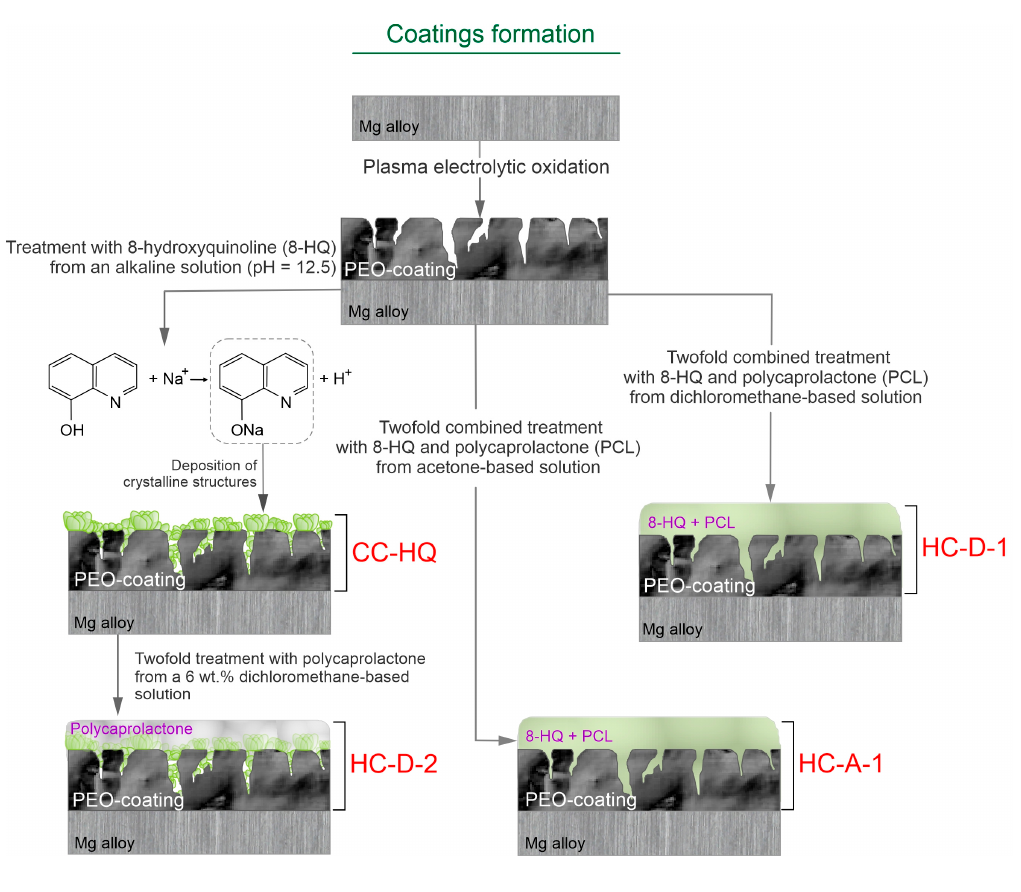
Figure 7. The detailed process of the base and inhibitor-containing coatings’ formation.